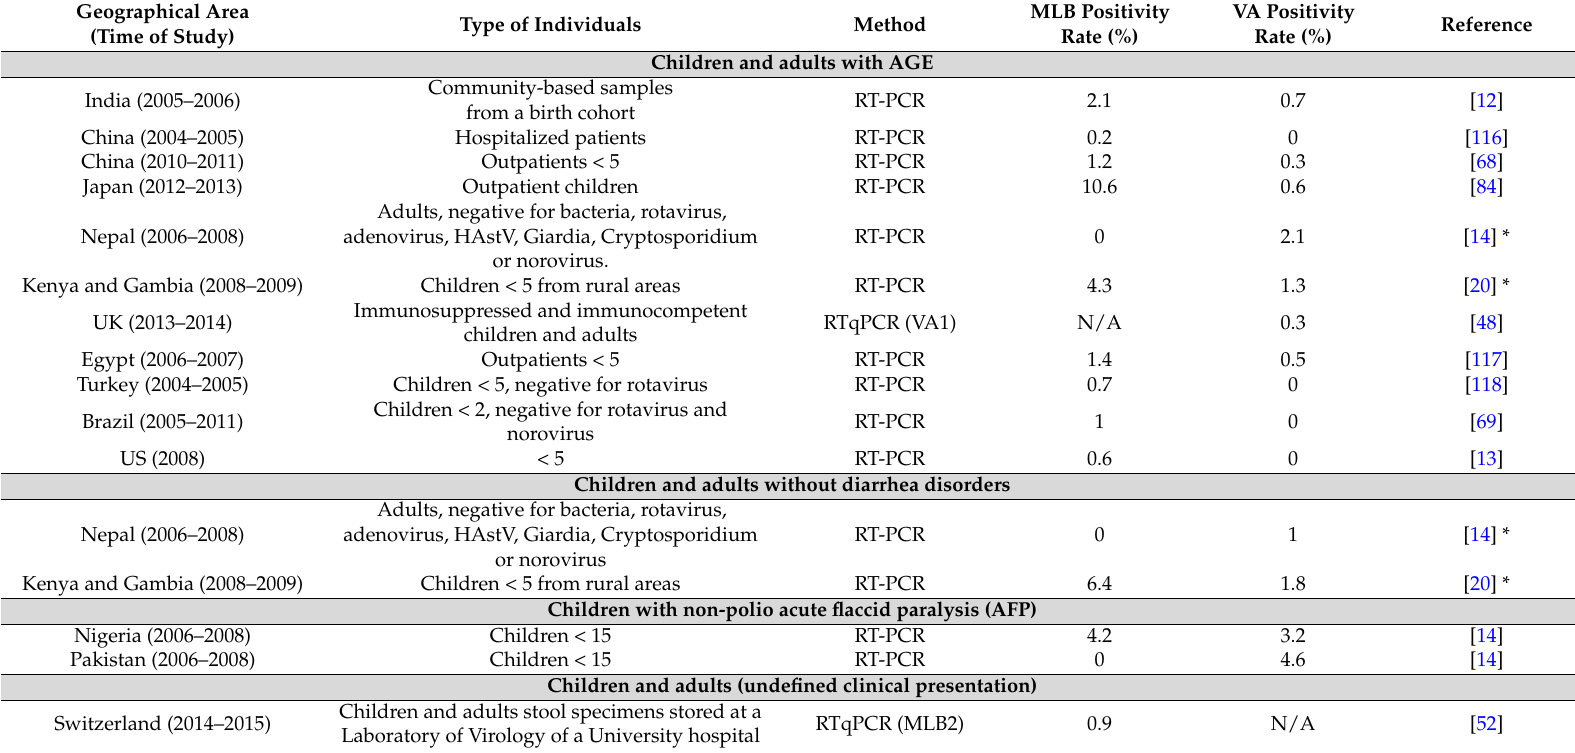
Table 4. Major epidemiological studies to determine the MLB-HAstV and VA-HAstV positivity rate in stool